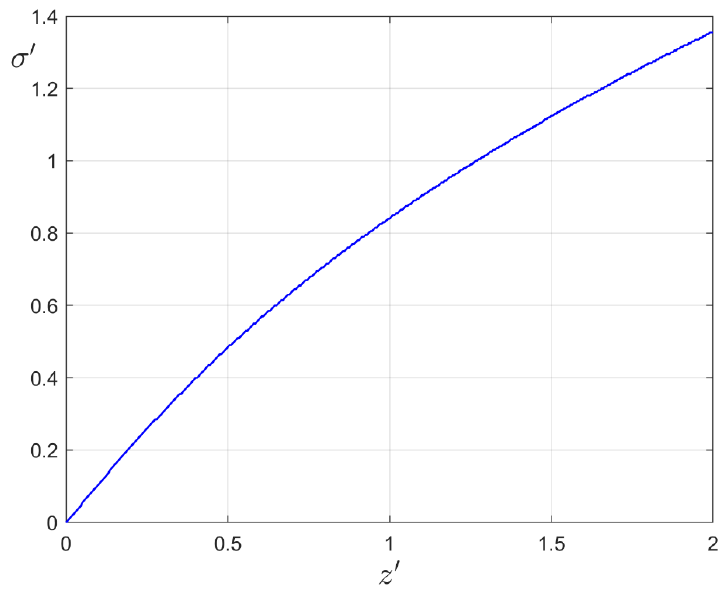
Figure 5. The plot of the parameter 𝜎 0 dependence on the distance to the film 𝑧′ . The value 𝜎 0 increases monotonously as the distance from the substrate atoms in- creases. The potential of the atom ’ s chain is approximated by the formula with two terms at the point 𝜎 0 .